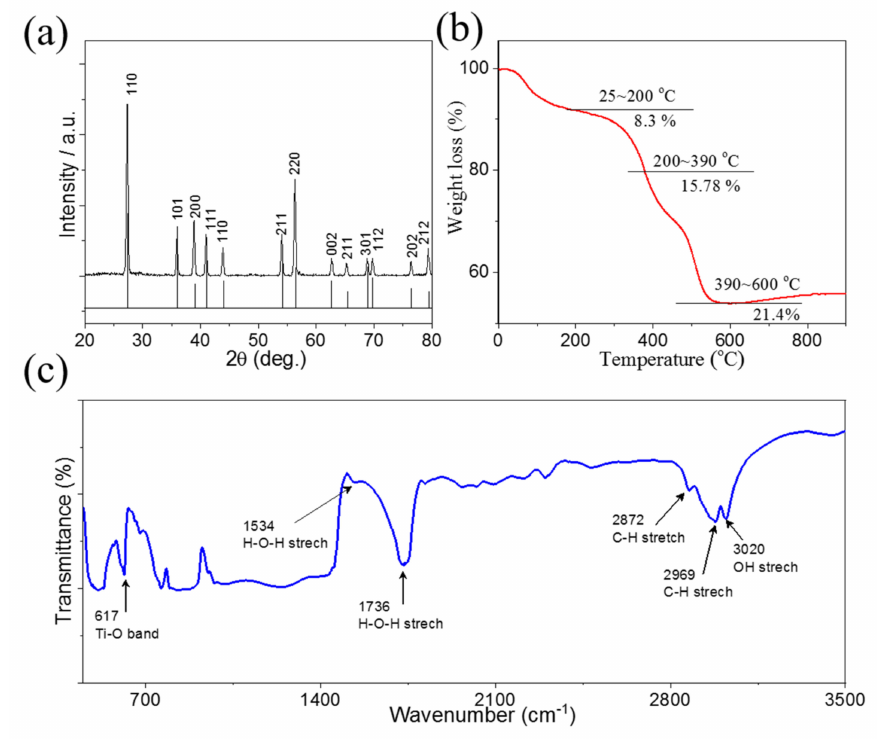
Figure 3. ( a ) XRD patterns of TiO 2 ; ( b ) TGA curve of TiO 2 ; ( c ) FTIR